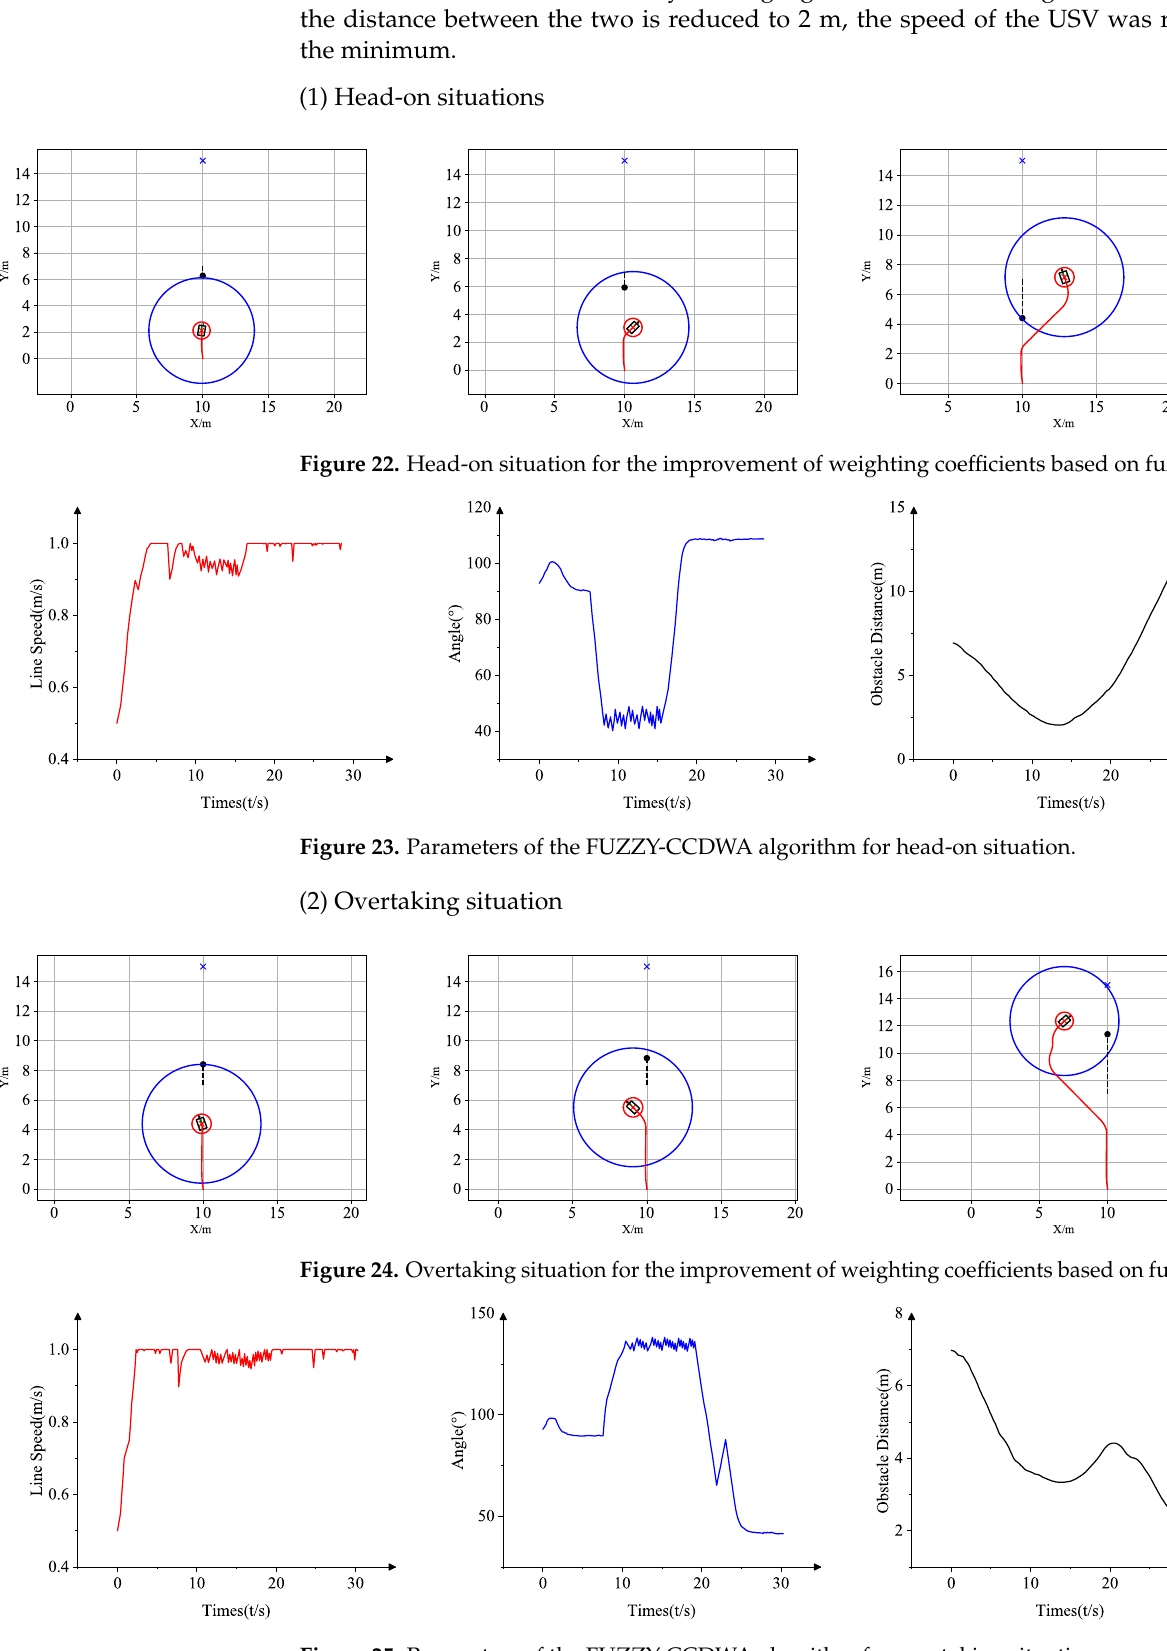
Figure 25. Parameters of the FUZZY-CCDWA algorithm for overtaking